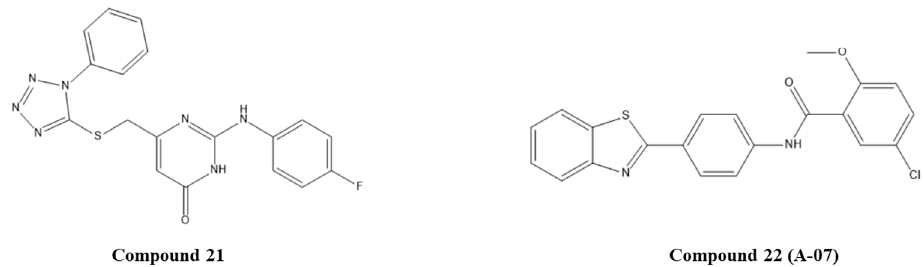
Figure 6. Structures of the studied synthetic compounds as E6/p53